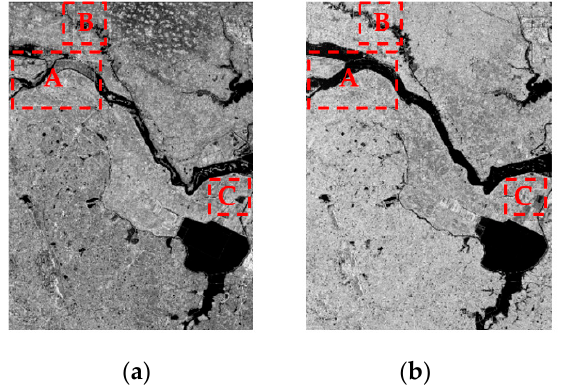
Figure 3. GaoFen-3 SAR images around Huaihe river. ( a ) Image acquired in January 2017. ( b ) Image acquired in October 2017.